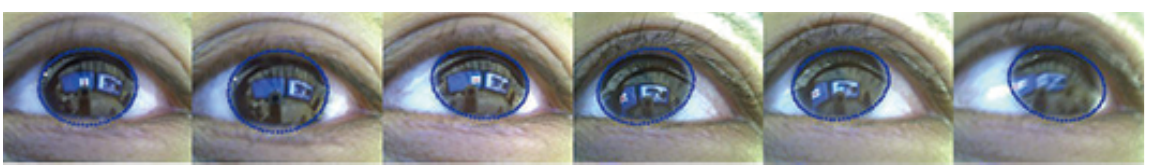
Figure 13 . Results of eye tracking using the 3D eye model. The estimated iris areas are indicated in blue.